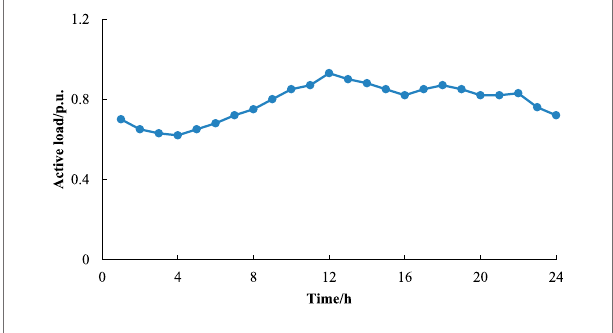
FIGURE 3 | Daily active load curve.